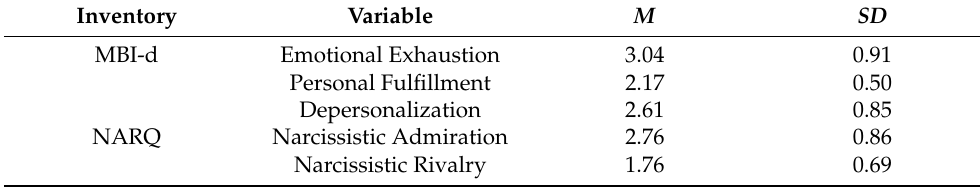
Table 2. Descriptive Statistics.